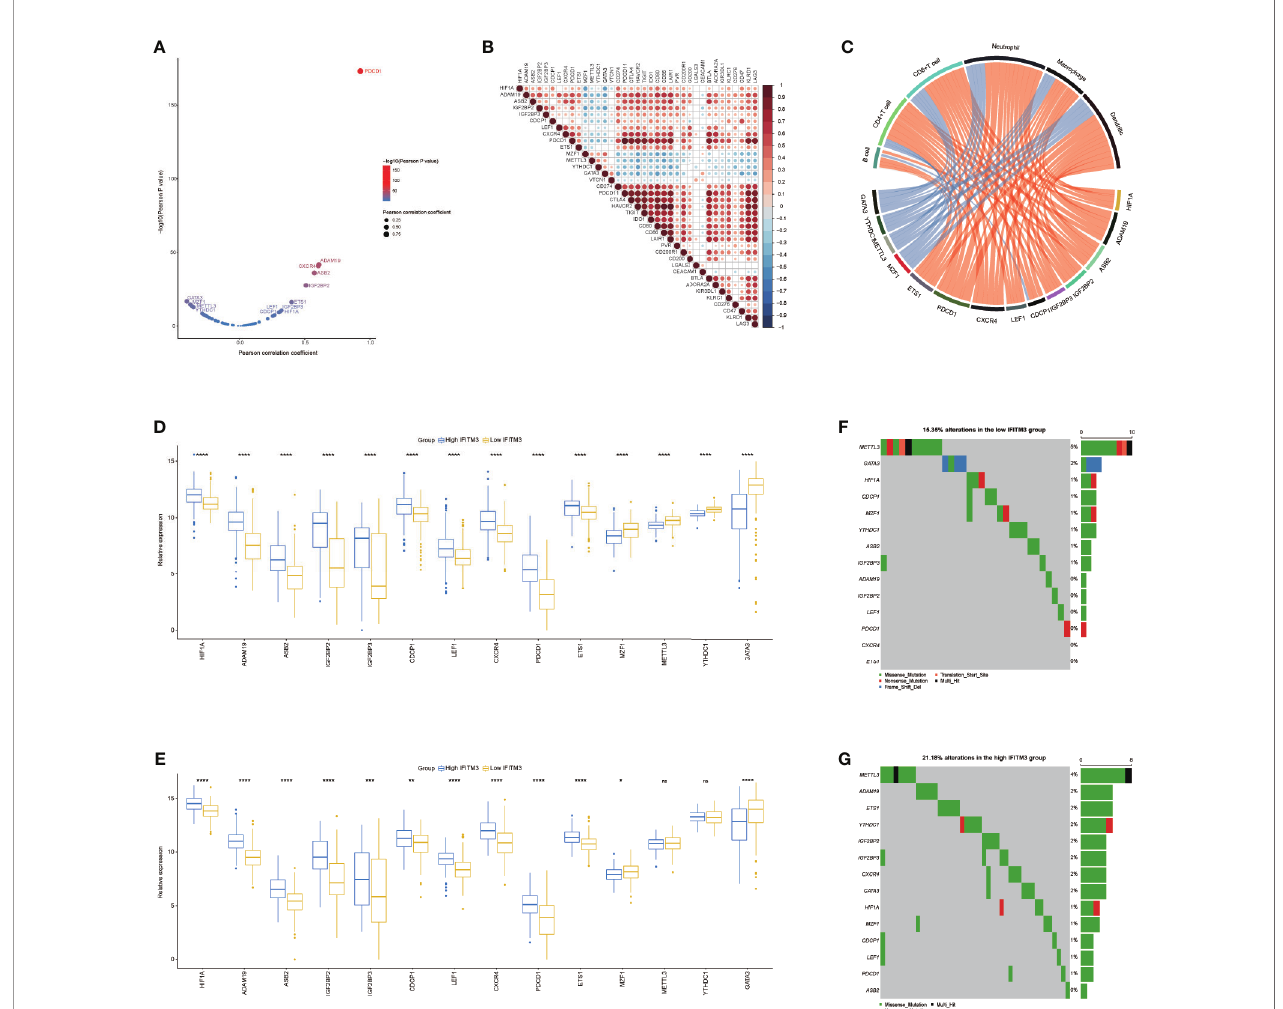
FIGURE 5 | Correlation between IFITM3 and m6A genes in BLCA. (A) Correlation between the T cell in fl amed score and m6A genes. The dots represent different m6A genes. The y -axis represents the Pearson correlation coef fi cient, while the x -axis represents − log 10 ( p -value). (B) Correlations between immune-related m6A genes and immune checkpoint expression. (C) Correlations between immune-related m6A gene expression and TIIC levels estimated by TIMER. (D, E) Expression levels of immune-related m6A genes in the high- and low-IFITM3 groups. (F, G) Mutational pro fi les of immune-related m6A genes in the high- and low-IFITM3 groups in the TCGA cohort. *p-value ≤ 0.05, **p-value ≤ 0.01, ***p-value ≤ 0.001, and ****p-value ≤ 0.0001. NS: no statistical signi fi